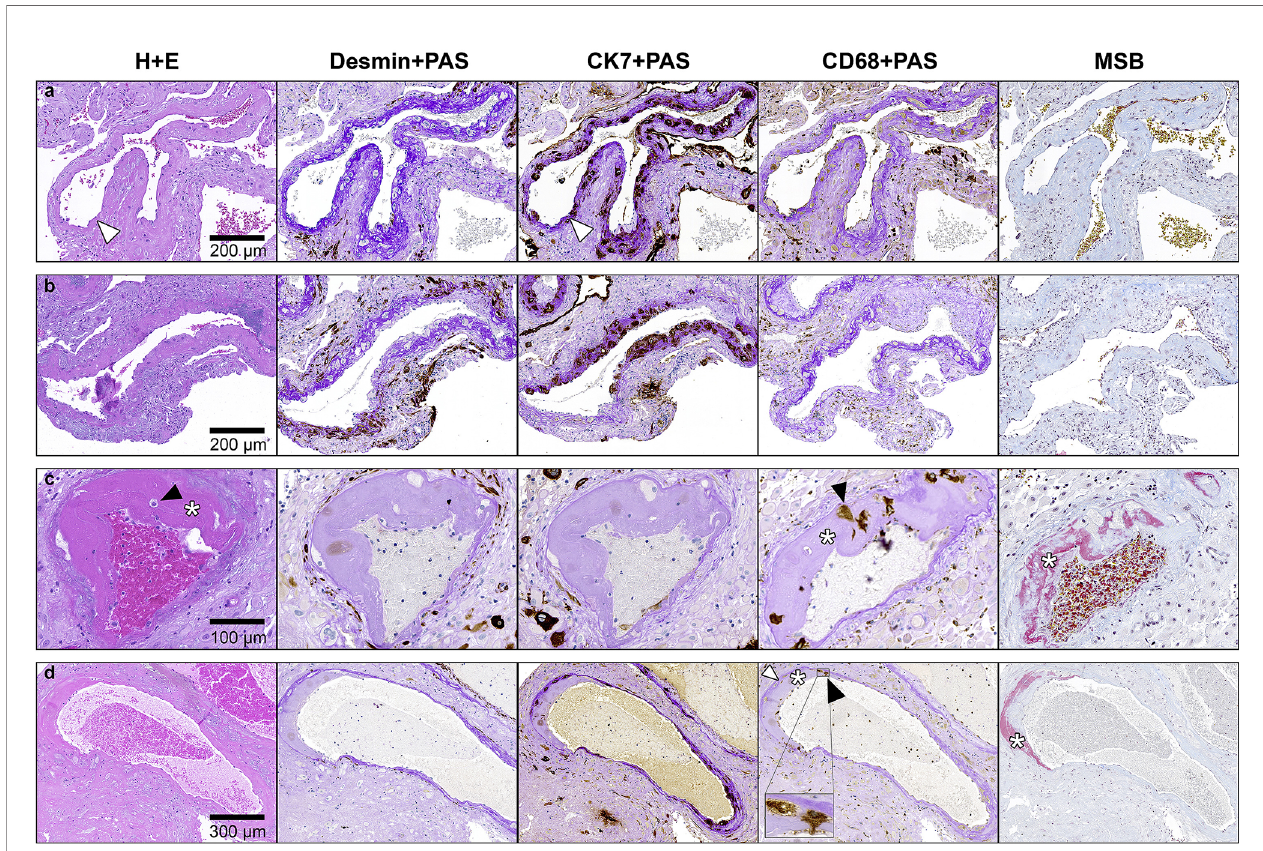
FIGURE 1 | Staining of serial FFPE sections of decidua basalis tissue to identify spiral arteries. Slides are stained with (from left to right) Hematoxylin + Eosin (H + E), desmin and Periodic acid – Schiff (PAS), cytokeratin 7 (CK7) and PAS, CD68 + PAS and Martius Scarlet Blue (MSB). Representative images of (A) spiral artery from a normotensive control with complete physiological transformation, characterized by presence of CK7-positive trophoblasts and intramural fi brinoid (bright purple upon PAS staining, white arrowhead) in the vessel wall, and complete absence of intramural smooth muscle cells (no desmin stain). (B) Spiral artery from a preeclampsia patient with partial physiological transformation characterized by intramural fi brinoid, trophoblasts and areas with traces of mural smooth muscle cells (desmin- positive). (C) Spiral artery with acute atherosis from same sample as in (B) , lacking bright purple fi brinoid and CK7-positive trophoblasts in the vessel wall. Traces of intramural smooth muscle cells (desmin positive) are seen. Fibrinoid necrosis is visible as a grey-pink material in the vessel wall (asterisk), which stains red upon MSB staining (asterisk). Erythrocytes in the lumen of the AA artery stains red-brown upon MSB staining. Intramural CD68-positive foam cells are present (black arrowhead). (D) Spiral artery from a preeclampsia patient with almost complete physiological transformation – evident by the lack of desmin-positive smooth muscle cells and the presence of CK7-positive trophoblasts – yet acute atherosis lesion is present (asterisk; fi brinoid necrosis, black arrowhead; foam cells, white arrowhead; purple physiological fi brinoid). Inset; higher power inset of foam cells. Reprinted from Fosheim et al. (35), with permission from the journal Placenta